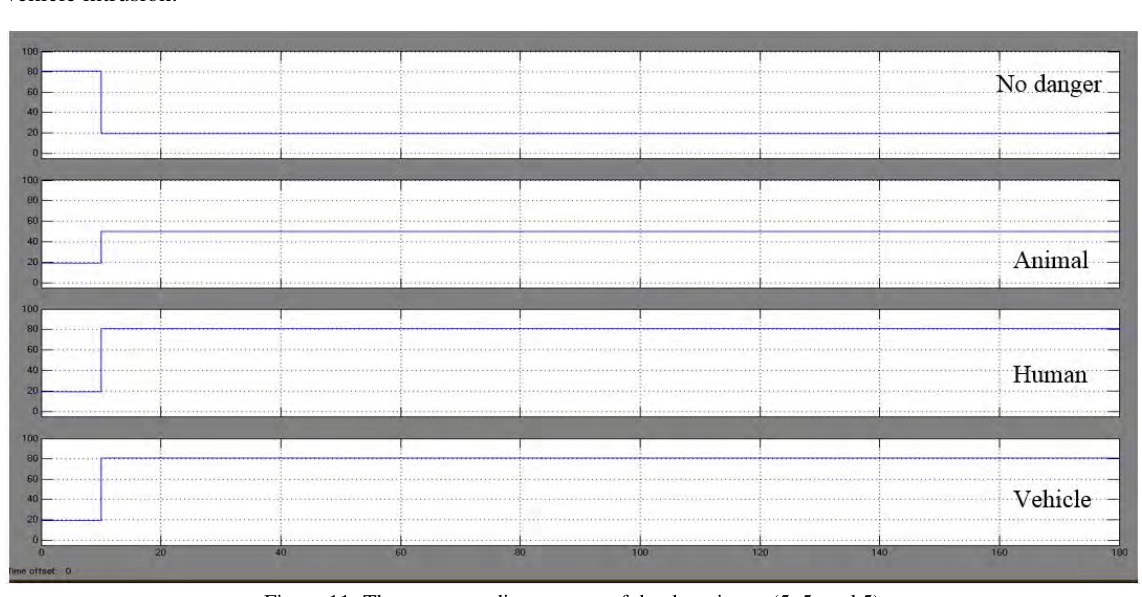
Figure 11. The corresponding outputs of the three inputs(5, 5, and 5)